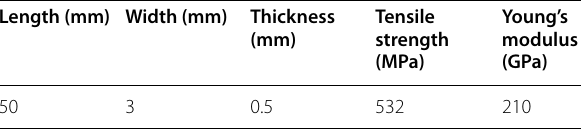
three beams for flexure strength testing. The specimens were cured in normal pure water at 27 °C (as shown in Fig. 9) prior to testing and after being shaped at one day old. Figure 11 shows some of the specimens after they have been cast and cured.